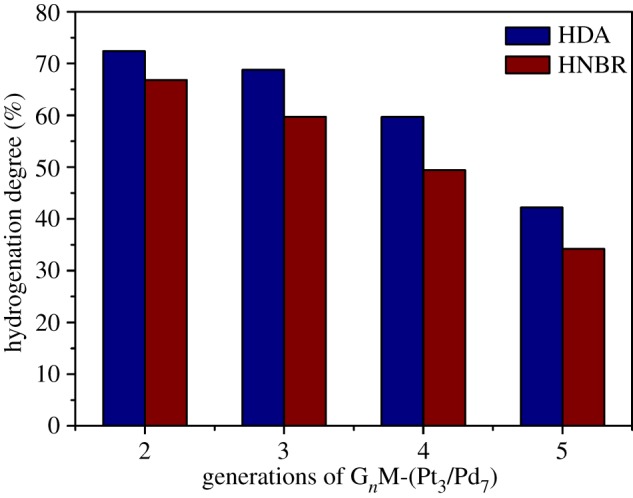
The effects of generations of Gn-(Pt3/Pd7) (n = 2, 3, 4, 5) on the HD of HDA and HNBR.